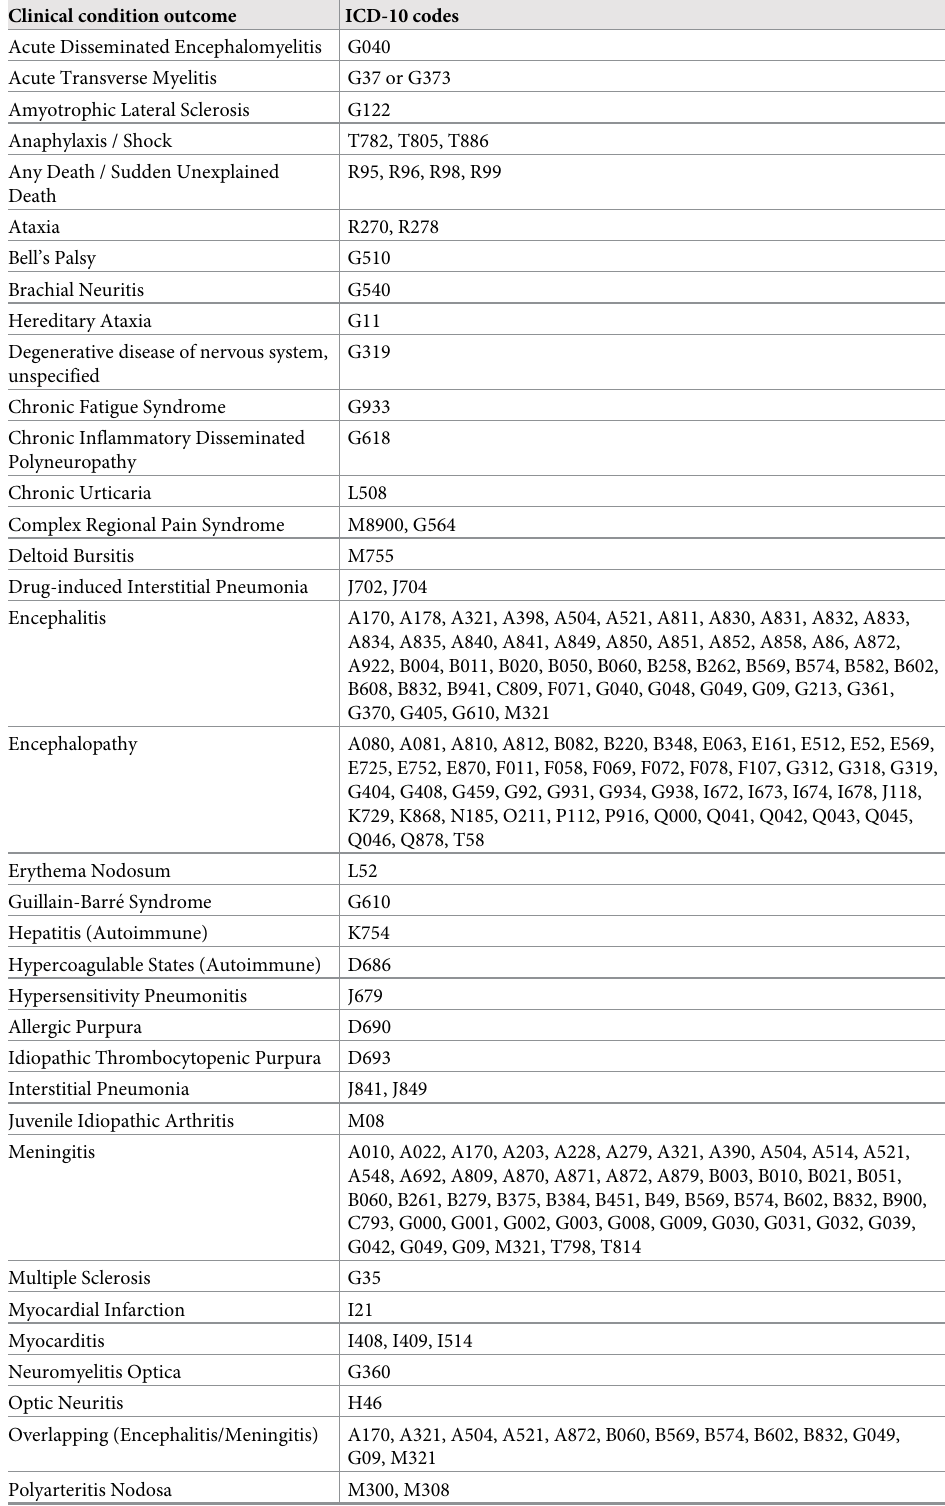
Table 1. ICD-10 codes used to identify clinical condition